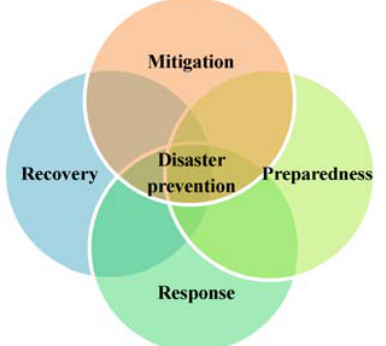
Figure.1 Conception of disaster prevention